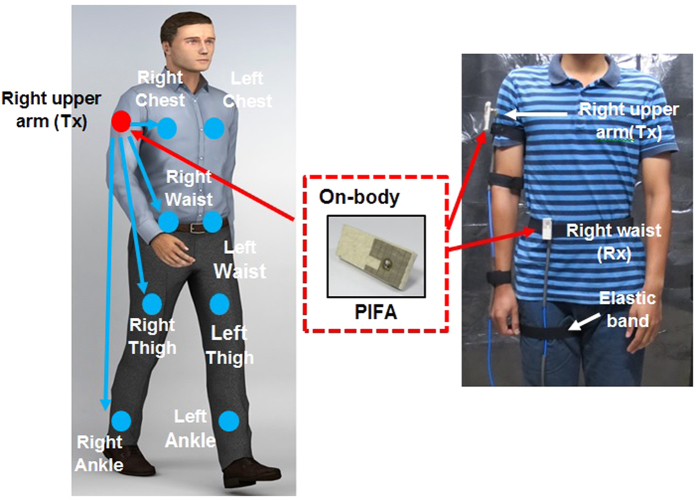
Measurement setup for narrowband channel on-body characterization (a) Tx and Rx locations on-body (b) measurement in an RF shielded room45.